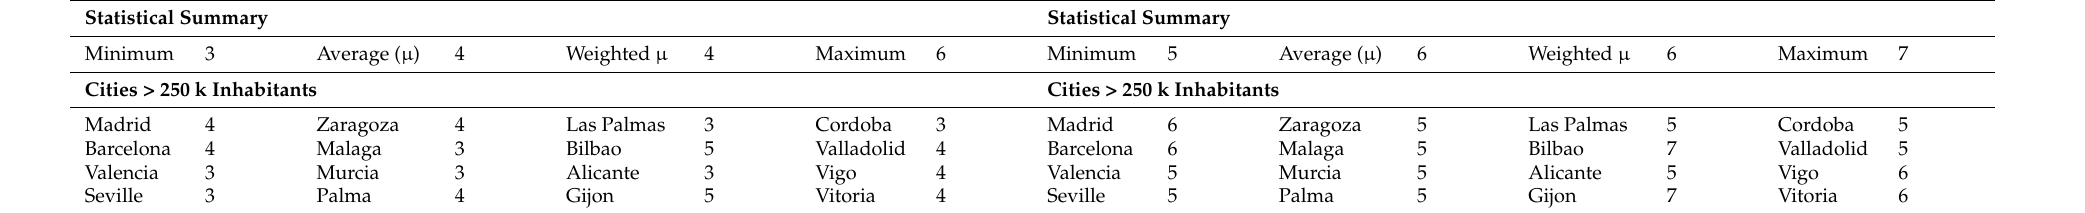
Figure 10. Ratio effort in cost-energy production for PV ( left ) and ST ( right ) installations in € cents/kWh. Table 20. Ratio effort in cost-energy -production for PV ( left ) and ST ( right ) installations in €